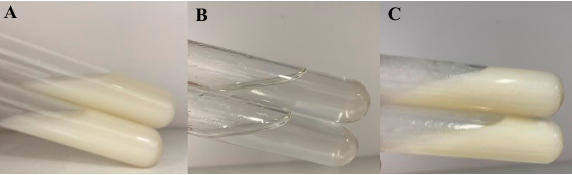
Figure 2. Pharmaceutical preparations ( A ) TMPZ-L; ( B ) TMPZ-G; ( C ) TMPZ-LG.